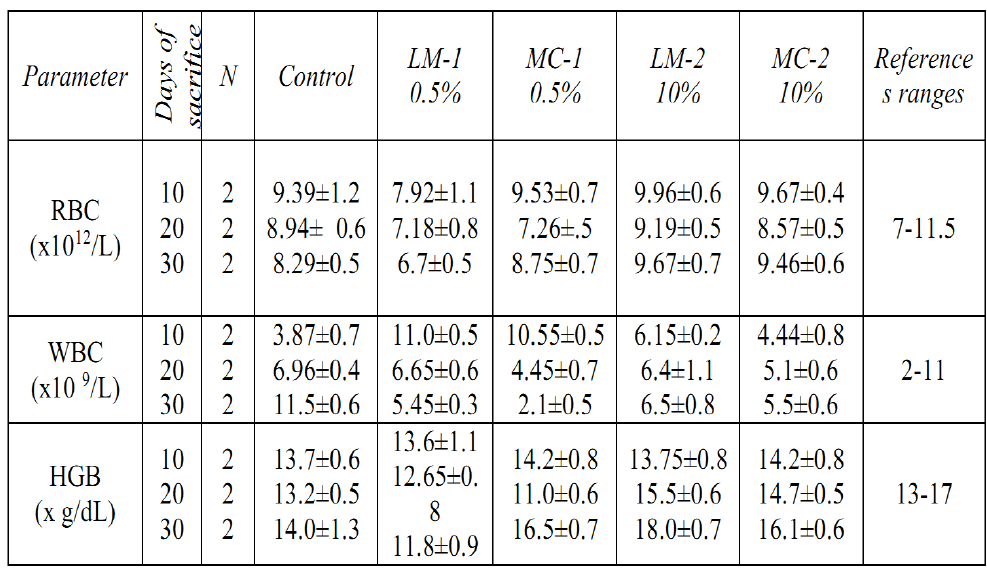
Table 5. Parameters of peripheral blood